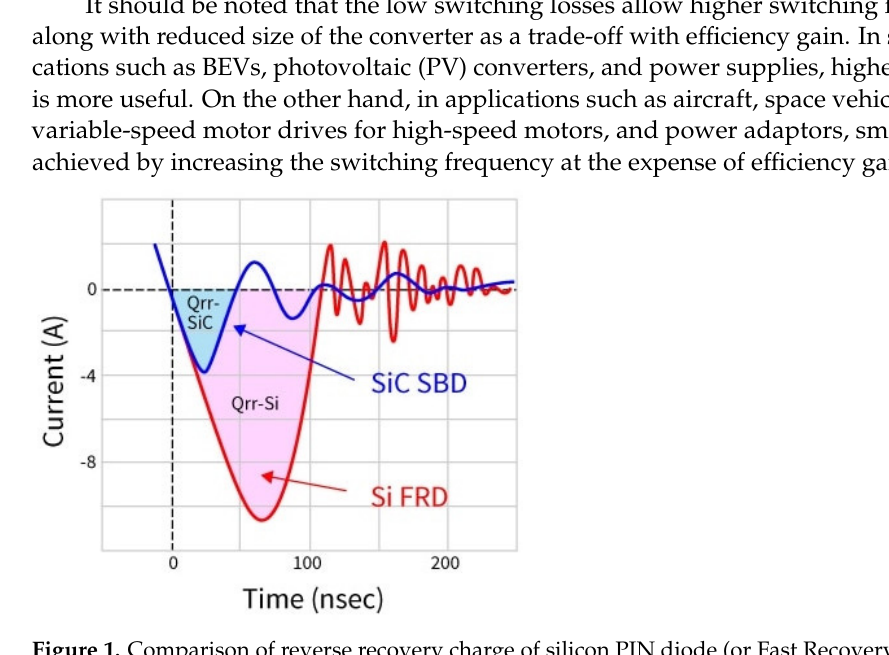
Figure 1. Comparison of reverse recovery charge of silicon PIN diode (or Fast Recovery Diode) and SiC Schottky diode [8].